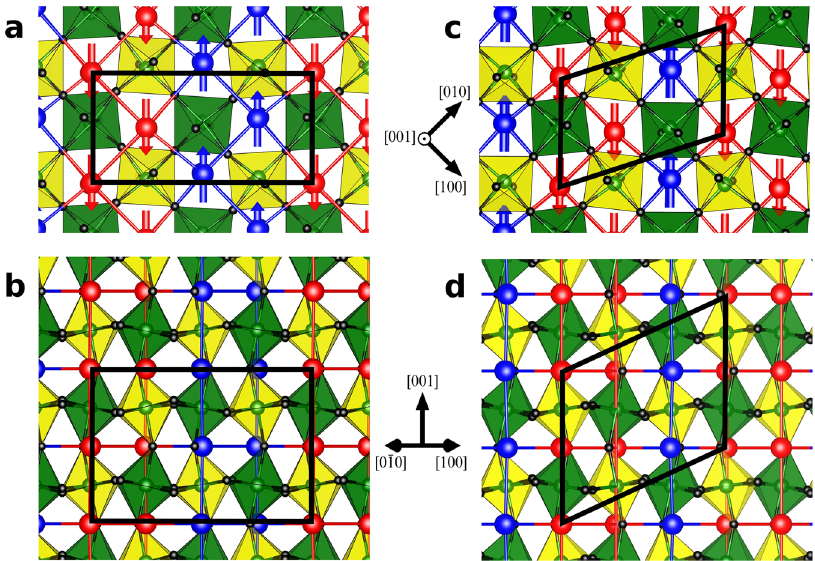
Fig. 1 Crystal structure of the AFE 40 and FiE phases of PbZrO 3 . Top ( a , c ) and side ( b , d ) views of the AFE 40 (left panels) and FiE states (right panels) are displayed. The primitive cells are marked with a black line. The Zr and O atoms are shown in green and black, respectively. Pb atoms are coloured in red and blue for positive and negative displacements, respectively. The oxygen octahedra are coloured in green and yellow alternatively (according to their displacements given by the R -point instability) as a guide to the eye.